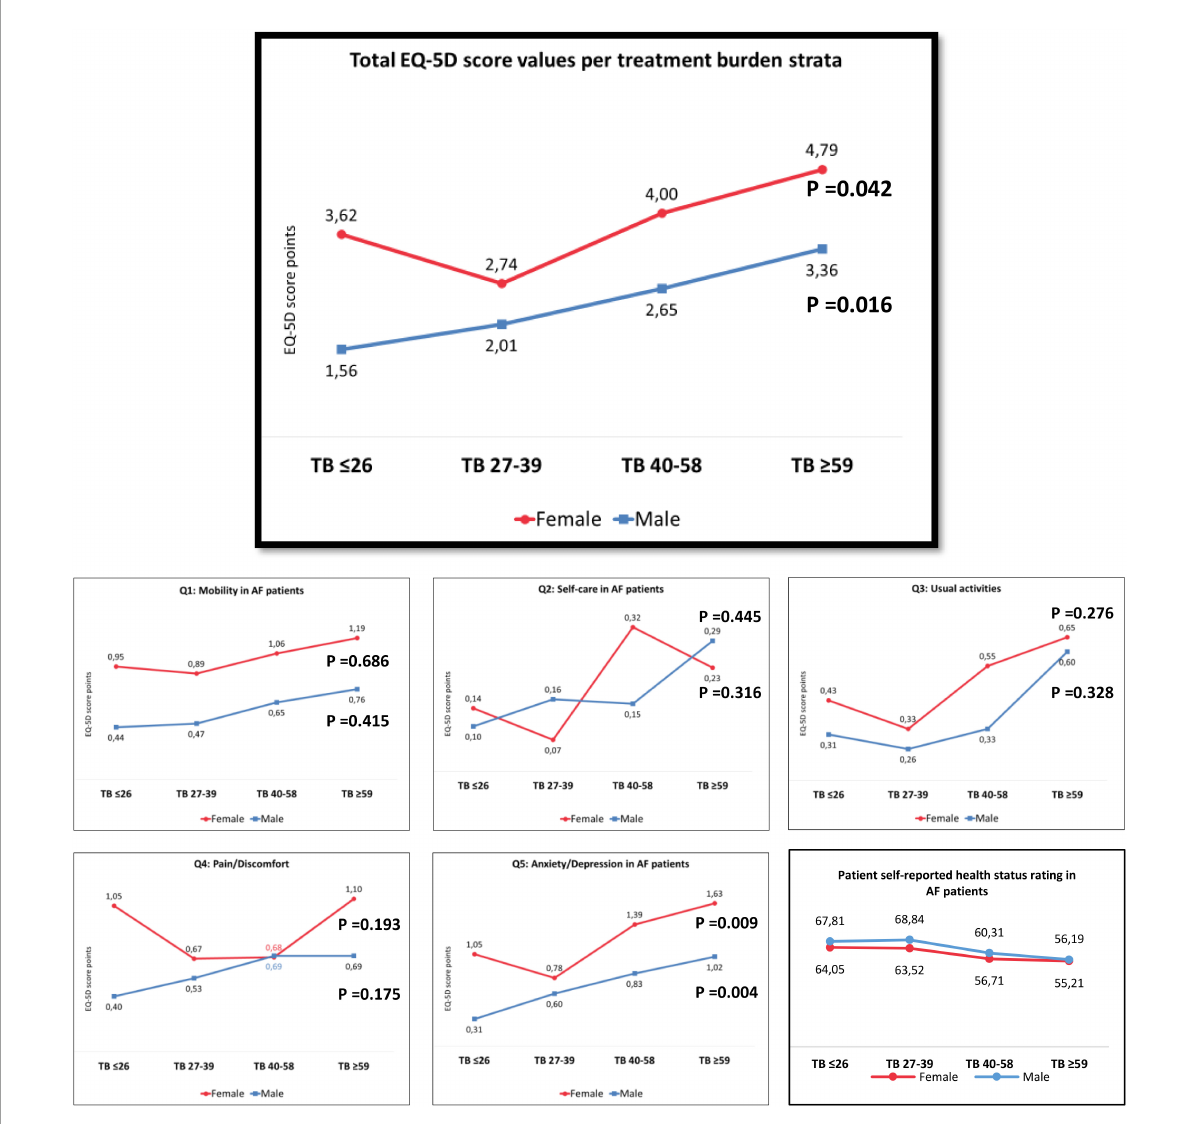
FIGURE4 Sex difference in self-reported health rating and the EQ-5D score values across treatment burden